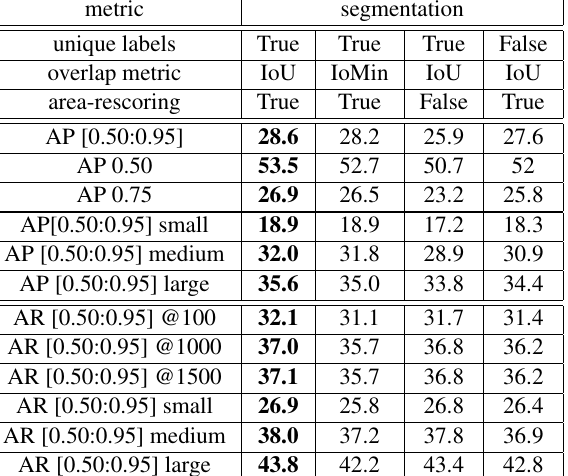
Table 2. ARM-NMS ablation results. We present the best mean average precision results under the defined settings.